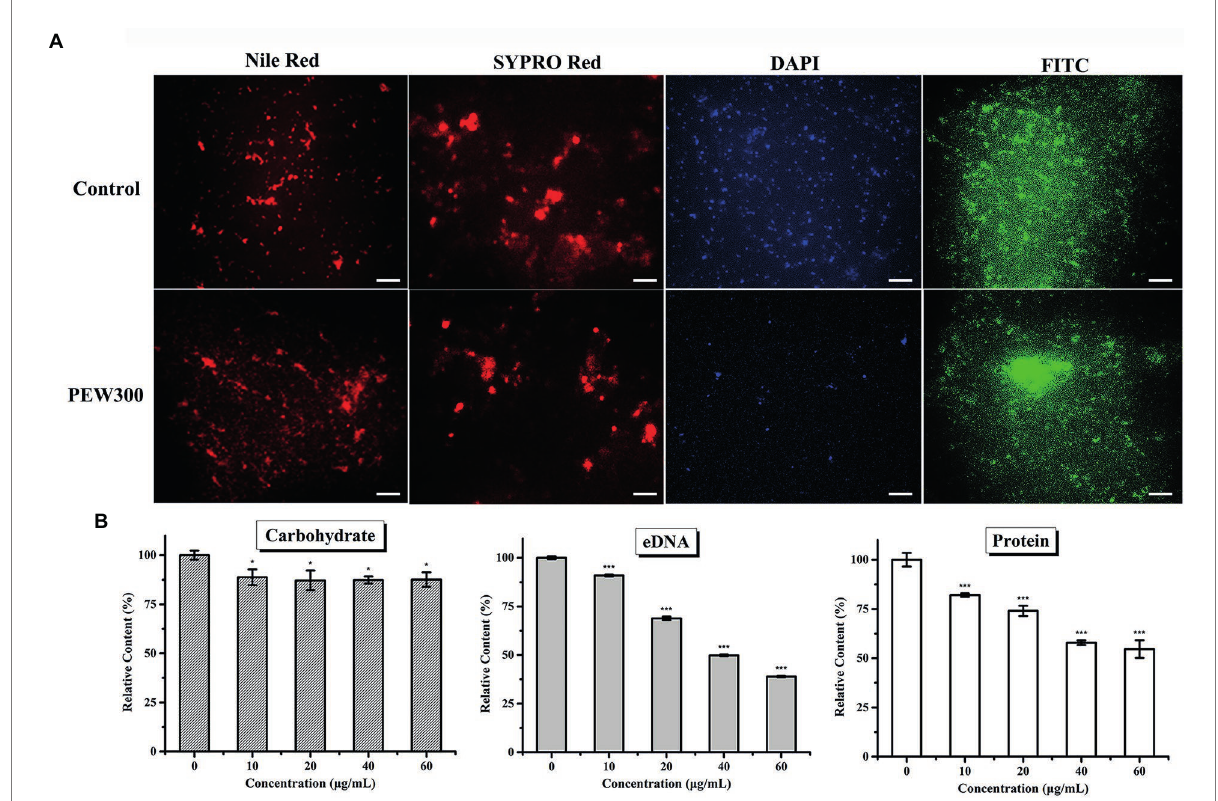
FIGURE 6 Eliminative action of PEW300 on Pseudomonas aeruginosa mature biofilm. (A) Fluorescence analysis of PEW300 on P. aeruginosa mature biofilm components. The scale bar is 200 μ m. (B) Quantification analysis of mature biofilms components of P. aeruginosa JCM5962 affected by PEW300. * Indicates statistical significance compared to the control groups (* p < 0.05; *** p <